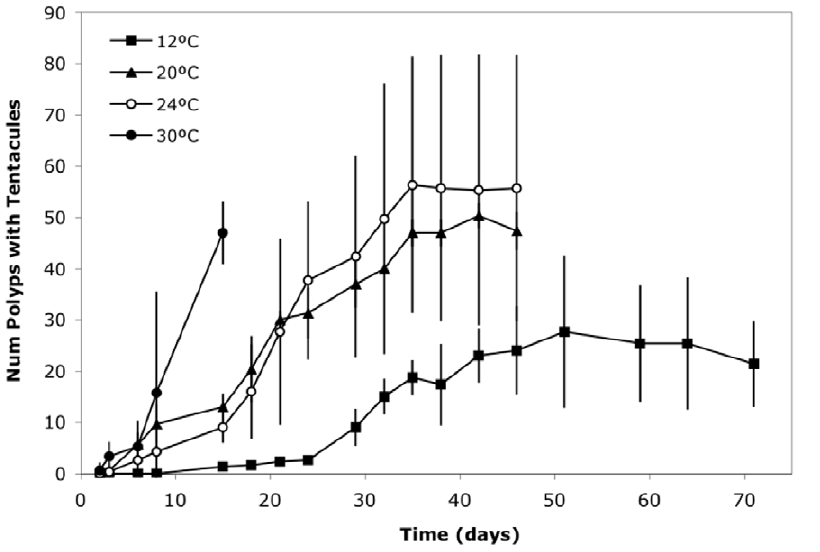
Figure 2. Number of planulae that fix and develop tentacles in different incubation temperatures (Experiment A). Filled Circle, empty circle, triangle and square stand for 30, 24, 20 and 12 u C, respectively. An experiment of 4 u C was also conducted but no polyps developed tentacles. Error bars are the standard deviations of the three replicates’.